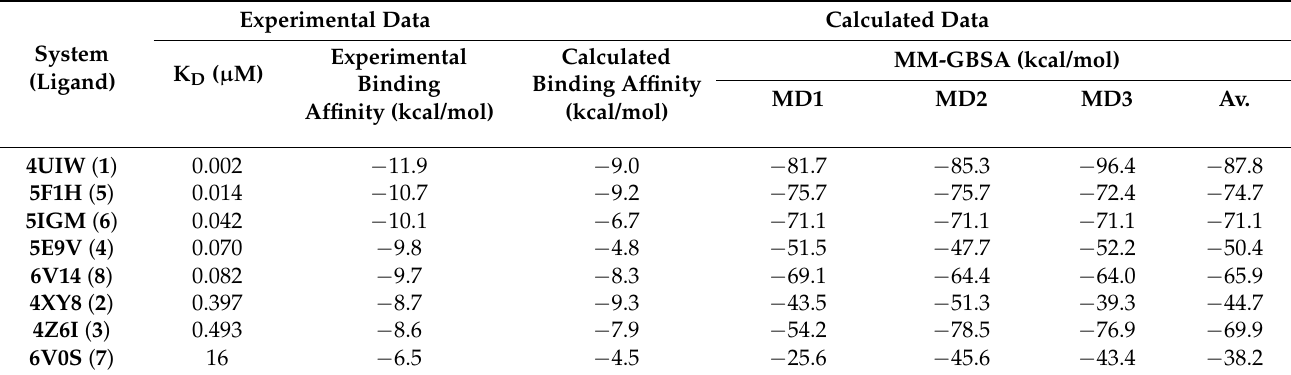
Table 1. Experimental K D [11,15,16,18,20–22] and binding free energies calculated with MM-GBSA method. The values reported for each MD are the mean of the 10 representative structures.